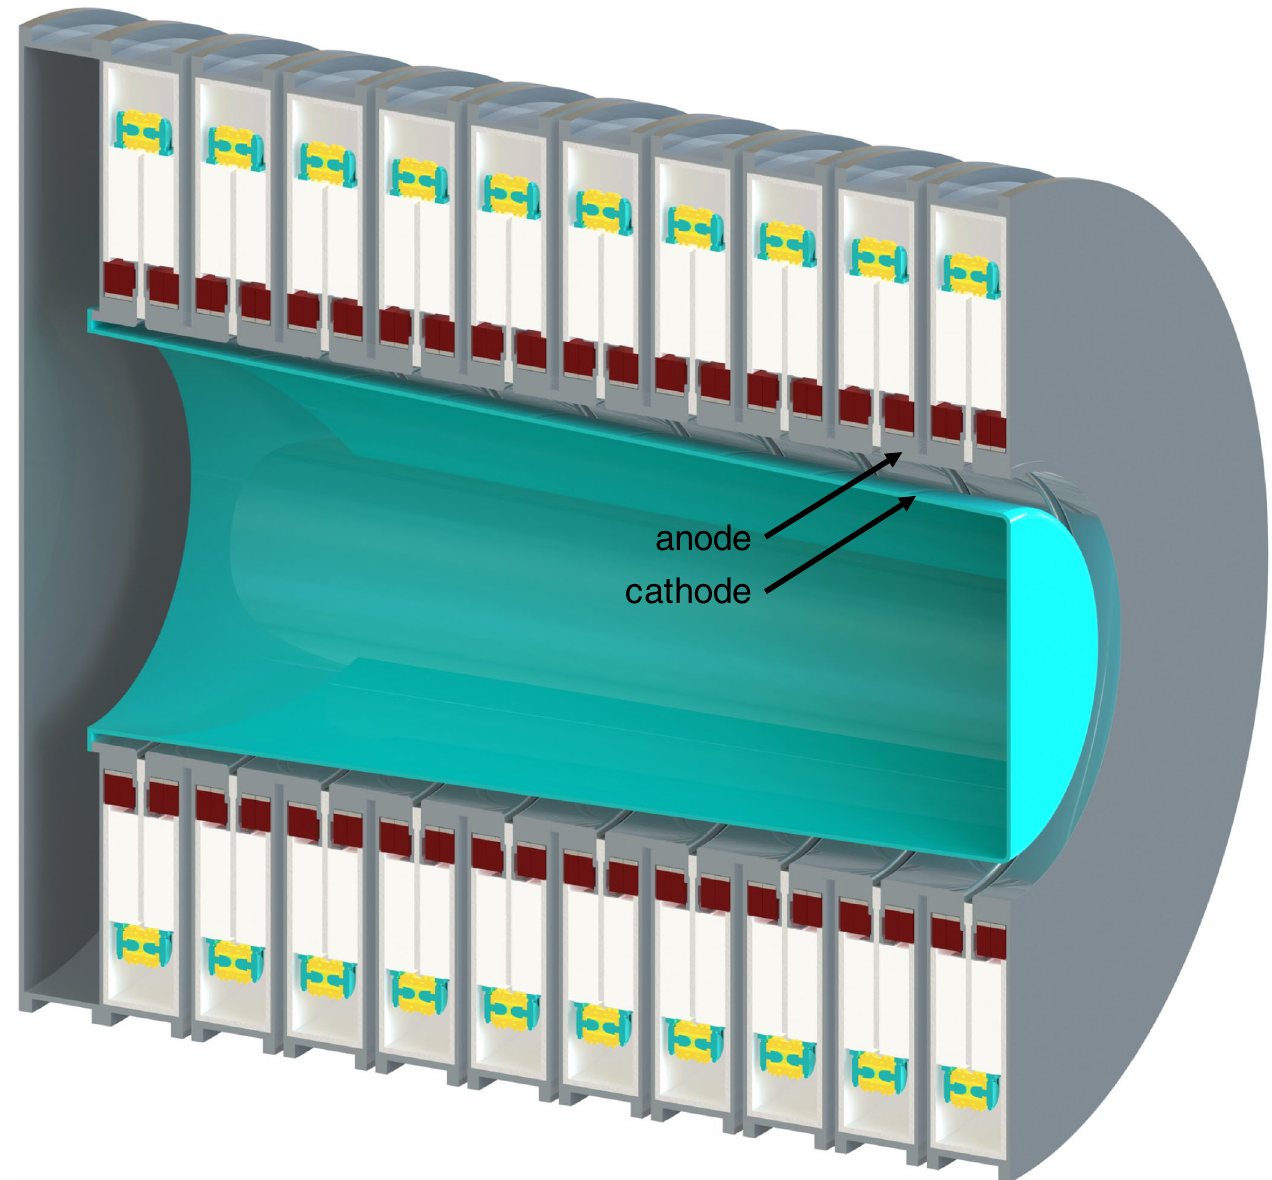
FIG. 1. Cross-sectional view of a ten-cavity linear-transformer-driver (LTD) module. The module is powered by 200 bricks altogether; only 20 are illustrated